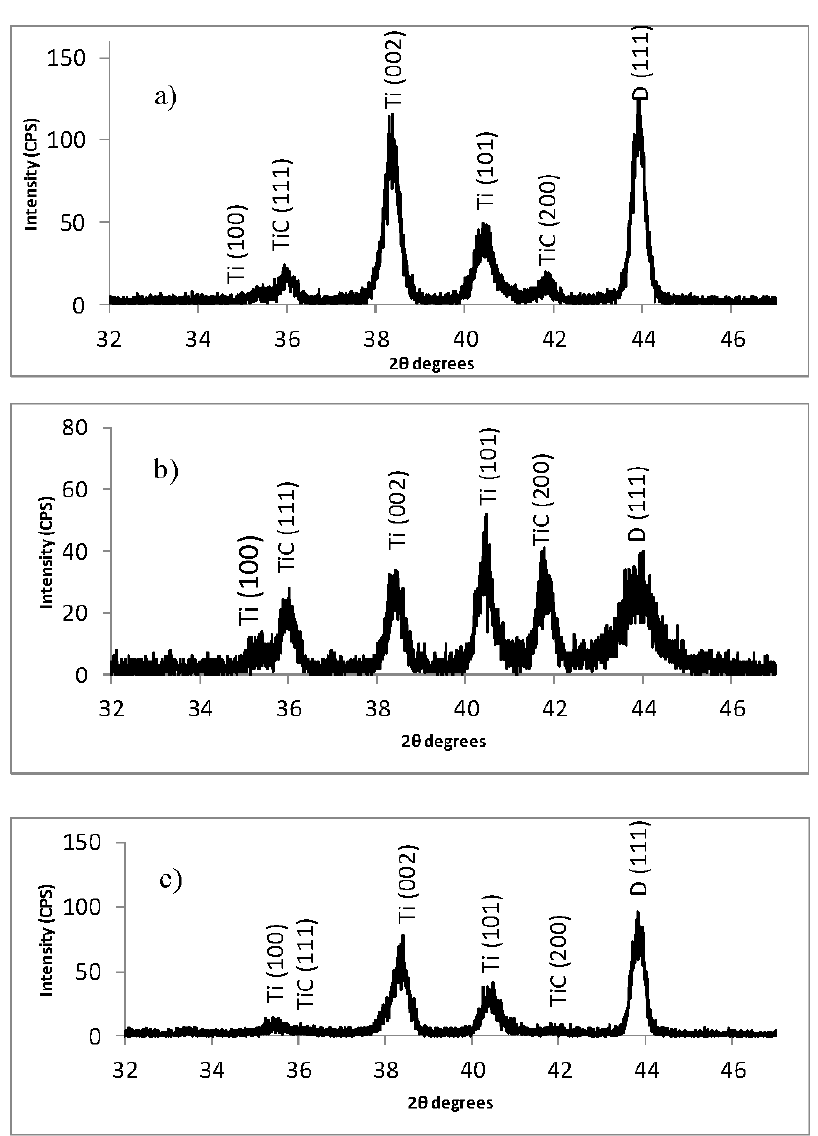
Figure 1. Thin-film X-ray diffraction patterns recorded with Cu K α radiation for diamond films on Ti-6Al-4V substrates. The diffraction peaks are identified for hcp Ti-alloy, cubic TiC, and cubic diamond (D) phases. ( a ) Microcrystalline diamond (MCD); ( b ) nanostructured diamond (NSD); ( c ) diamond deposited with nitrogen and boron (BND) exhibiting microcrystalline morphology.